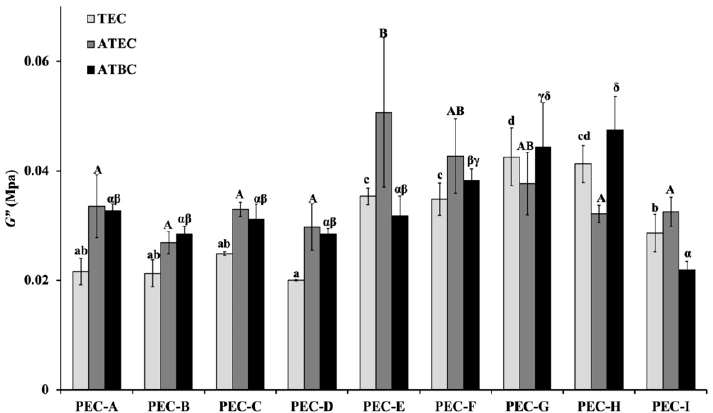
Figure 4. The loss modulus ( G” ) values at 1 Hz for materials before immersion. Identical letters indicate no significant differences ( p > 0.05).